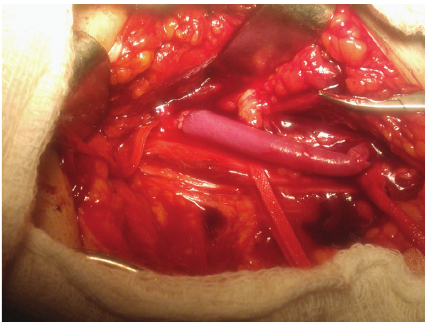
Figure 2: Intraoperative photograph showing repair of axillary artery using reversed basilic vein